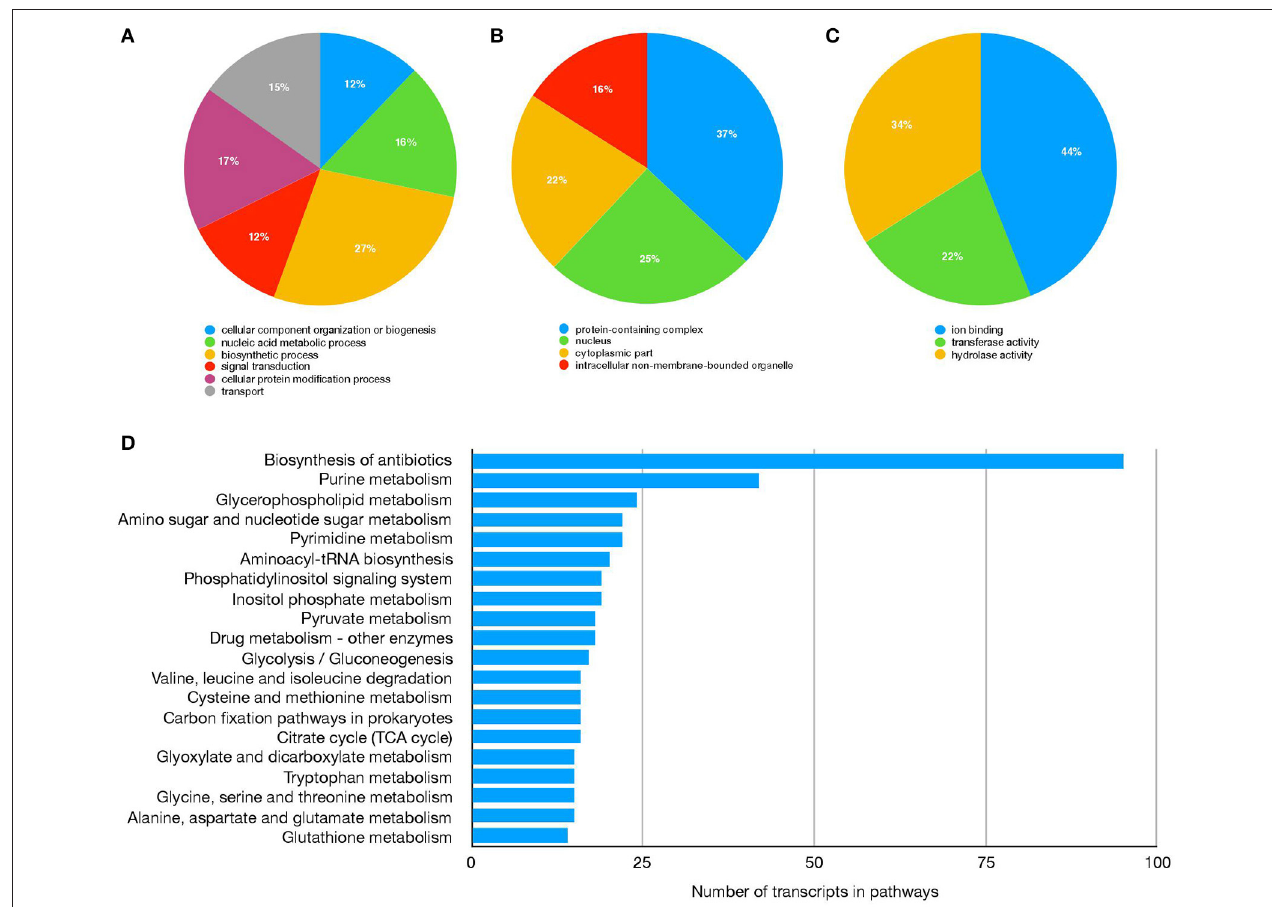
FIGURE 1 | R. ( B. ) microplus salivar gland transcriptome functional annotation. Transcripts distribution based on GO categories Biological process (A) , Cellular component (B) , and Molecular function (C) . Top 20 processes in KEGG pathways (D)